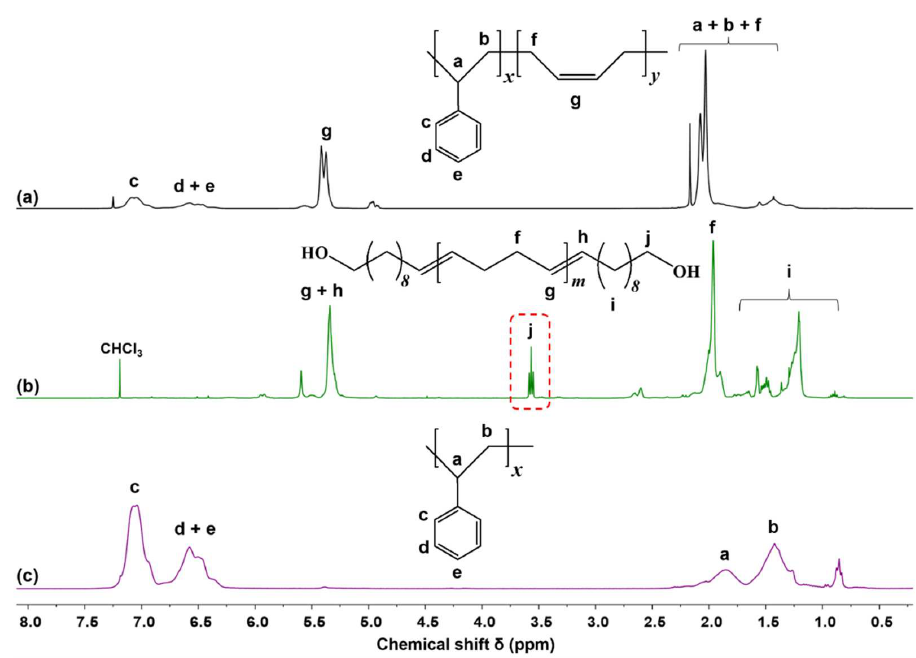
Figure 2. 1 H-NMR spectra (400 MHz, CDCl 3 , TMS) of ( a ) SBS, ( b ) biobased HTPB synthesized via metathesis degradation from SBS and 10-undecen-1-ol, and ( c ) polystyrene isolated and recovered (SBS1 entry, Table 1).